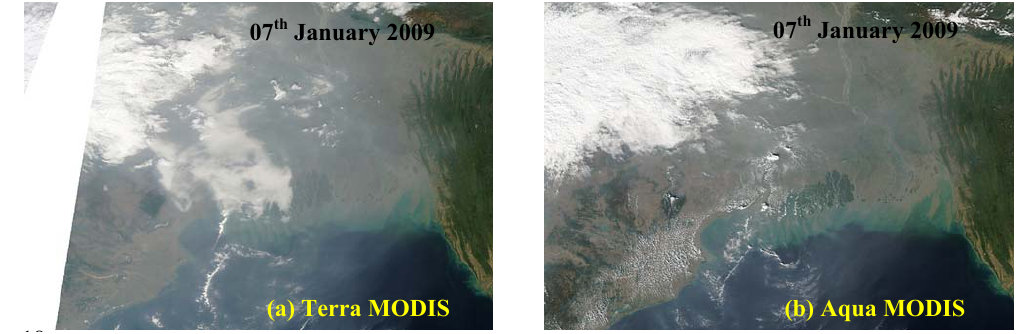
Fig. 6. True Color Composite images of Terra/Aqua MODIS on 7 January 2009 over the northern BoB.